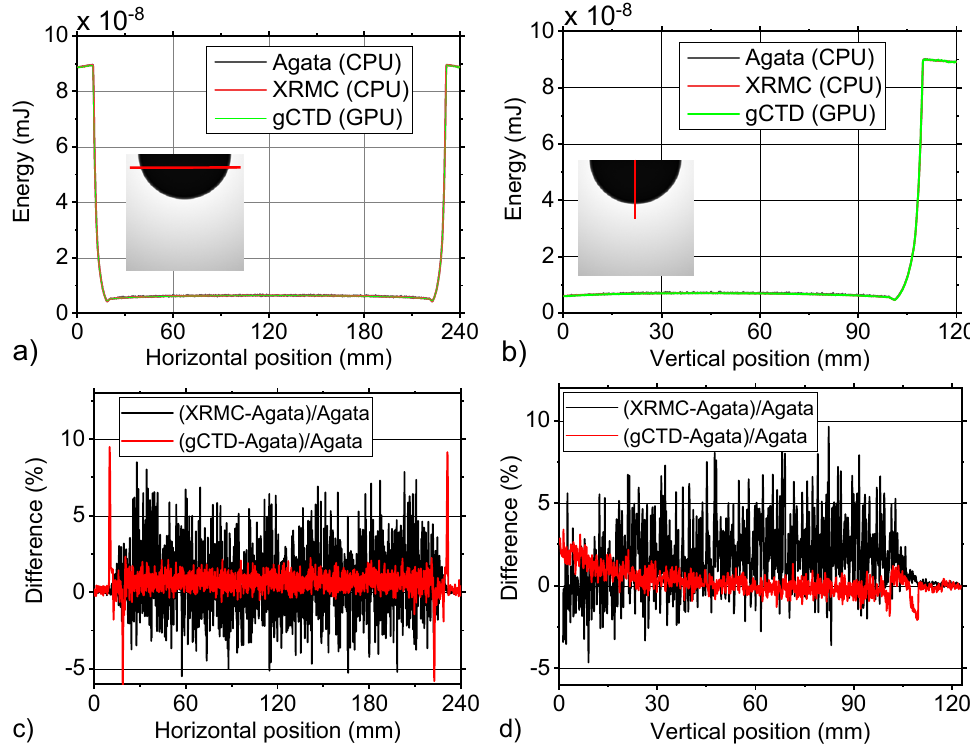
Figure 5. ( a ) Horizontal line profiles and ( b ) vertical line profiles of simulated deposited energy in each detector pixel with Agata Geant4, XRMC, and gCTD codes, respectively. The red lines indicate the position of the measured line profiles on the phantom images. ( c ) and ( d ) are shown as the percentage difference between the values that were provided by the three simulation codes that were reported in ( a ) and in ( b ), respectively.